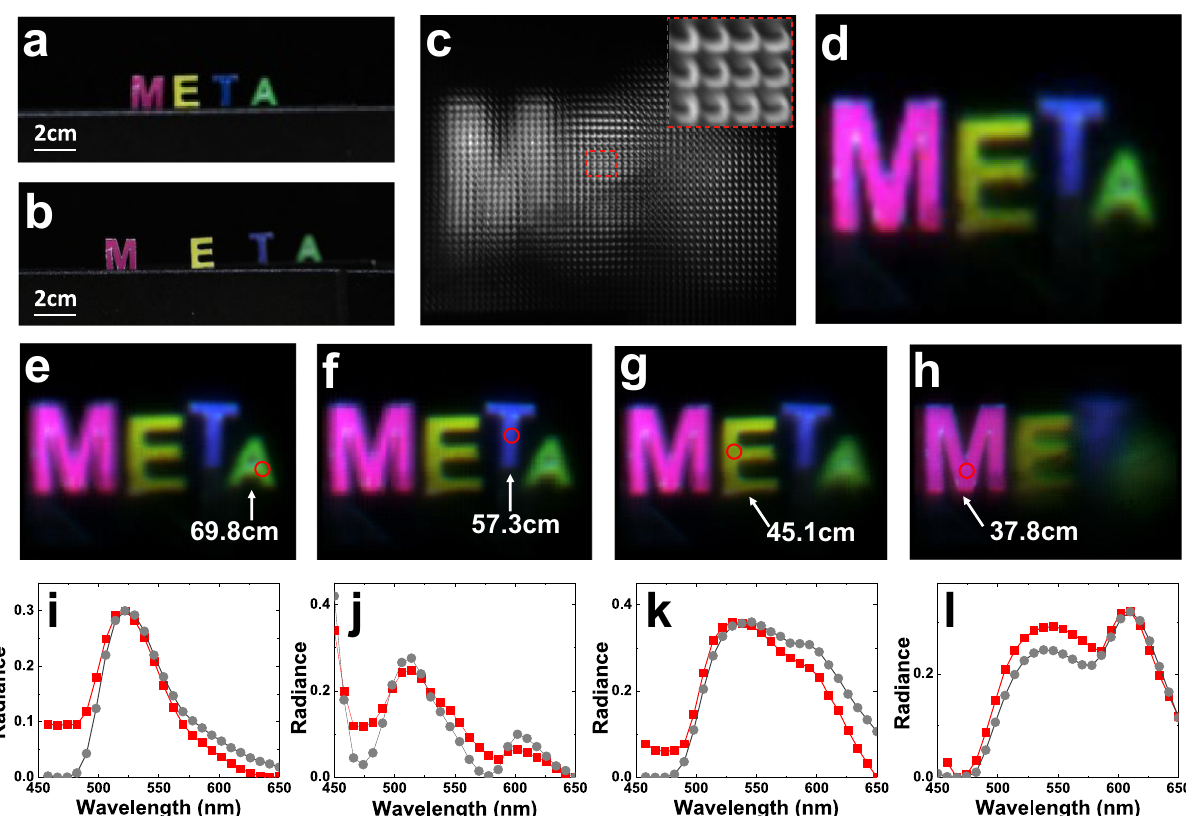
Fig. 4 The spectral light- fi eld imaging of metalens array. a , b Different view of the scene that consists of four letters with different color at different spatial positions. c The raw data of the SLIM system. The inset is the Zoomed-in images of area inside the red box. d The all focused rendered color image. Rendered images with focusing depths of 69.8 cm ( e ), 57.3 cm ( f ), 45.1 cm ( g ) and 37.8 cm ( h ). i – l Spectra of four letters. The red dot lines are the spectra reconstructed from the metalens array, and the gray dot lines are measured by commercial